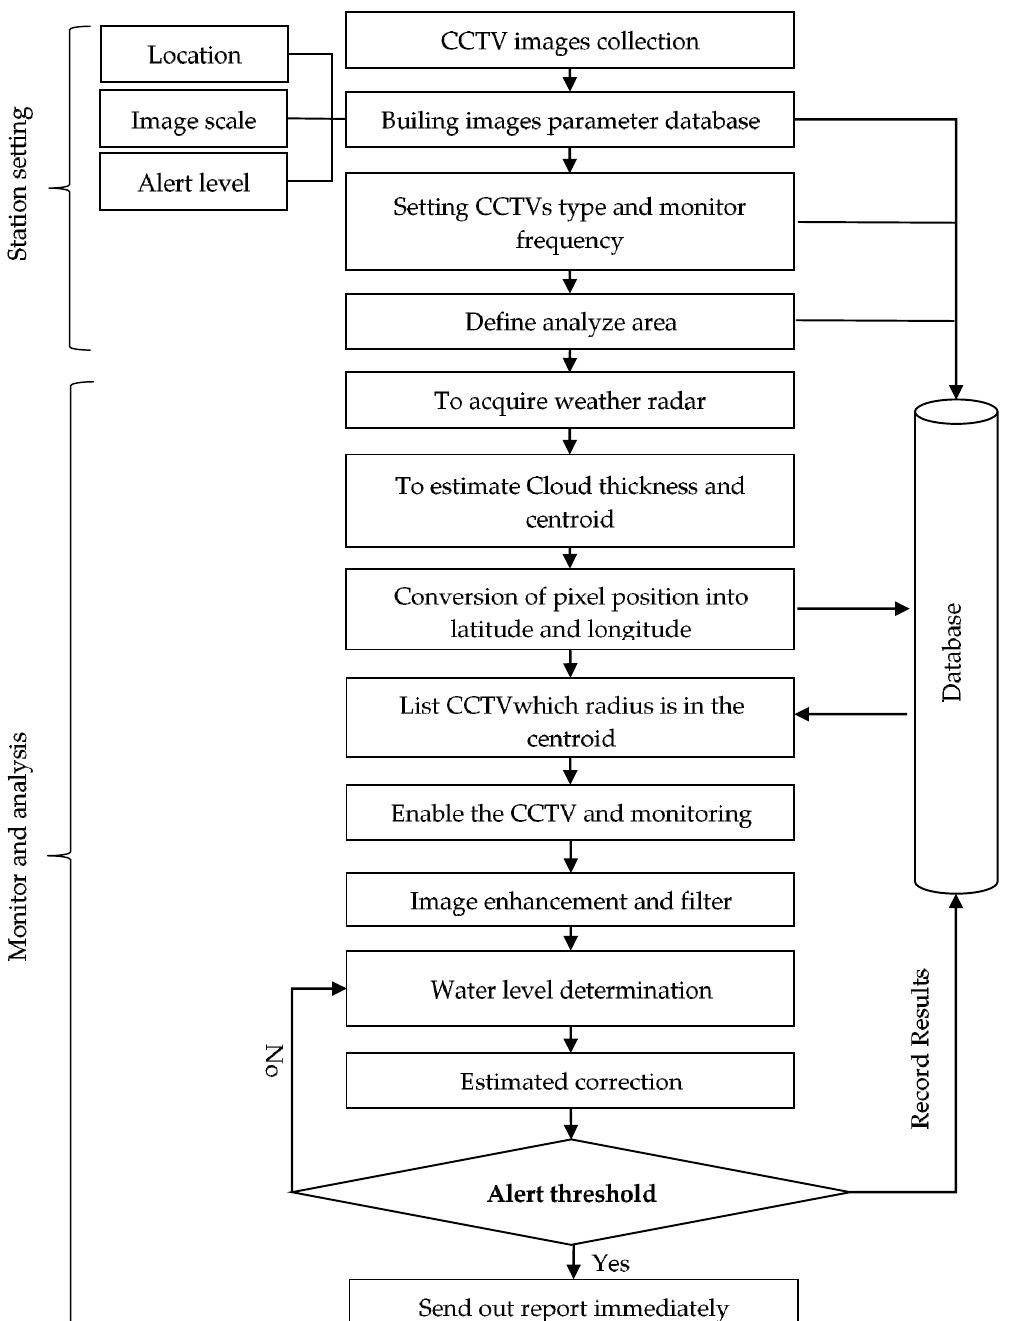
Figure 1. A flow chart of the automated urban flood monitoring system.